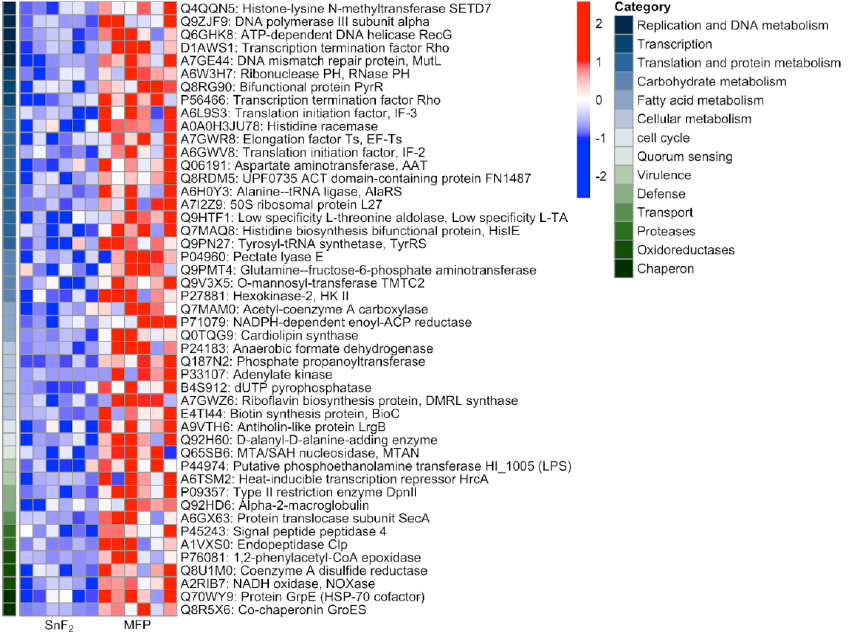
Figure 12. Heat map showing gene expression values of top genes correlated with sodium monofluorophosphate (MFP). Range of colors (red, pink, light blue, dark blue) shows the range of expression values (high, moderate, low, lowest).